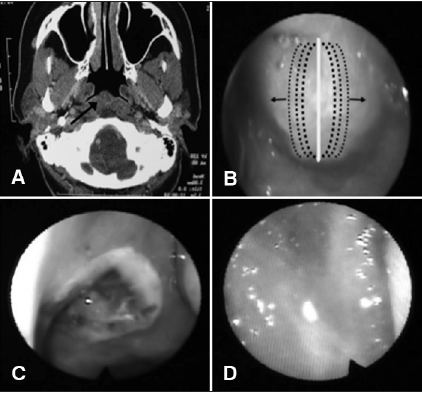
Figure 1. A: CT scan of the sinuses showing a lesion in the na- sopharynx; B: Direction of the vaporization of the free edges of the cyst; C: Appearance of the surgical injury on the second day postoperatively; D: Three months postoperatively, normal looking mucosa without signs of